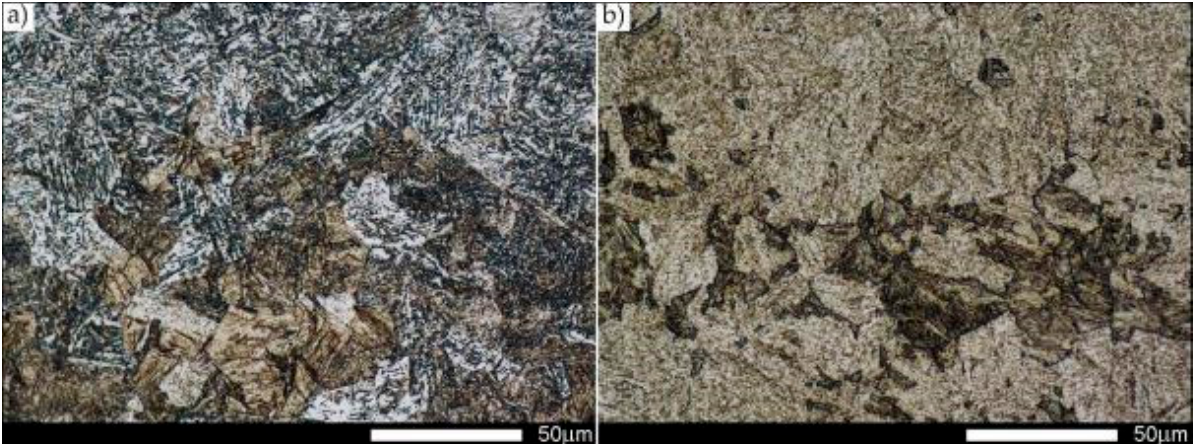
Figure 4. Hardox Extreme steel microstructure in normalized conditions. ( a ) Longitudinal orientation—hardness of 38 HRC. ( b ) Transverse orientation—hardness of 38 HRC. In both cases, quenched structures exhibit wide structural diversity with a great percentage of diffusion structures. Light microscopy, etched with 3% HNO 3 .